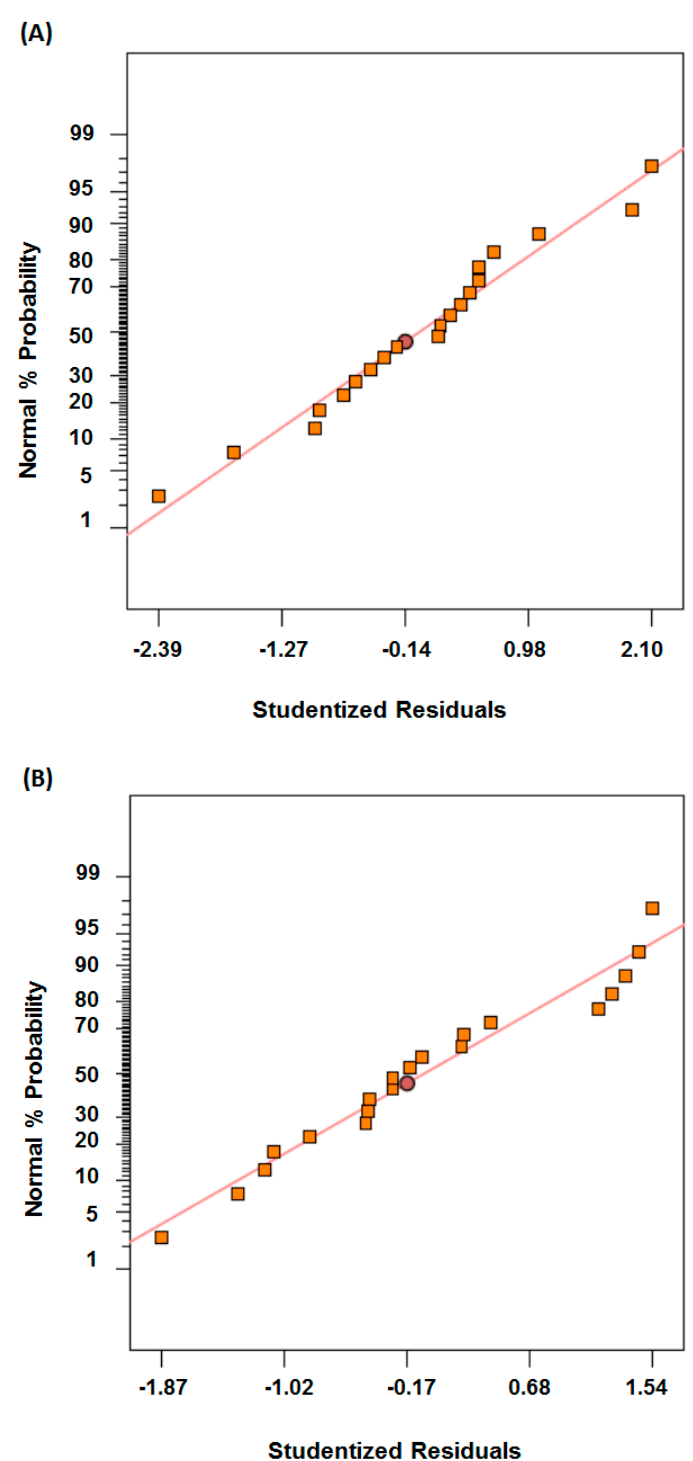
Figure 3. Plot of normal probability vs. studentized residuals ( A ) For tool diameter, T1; ( B ) For tool diameter, T2.